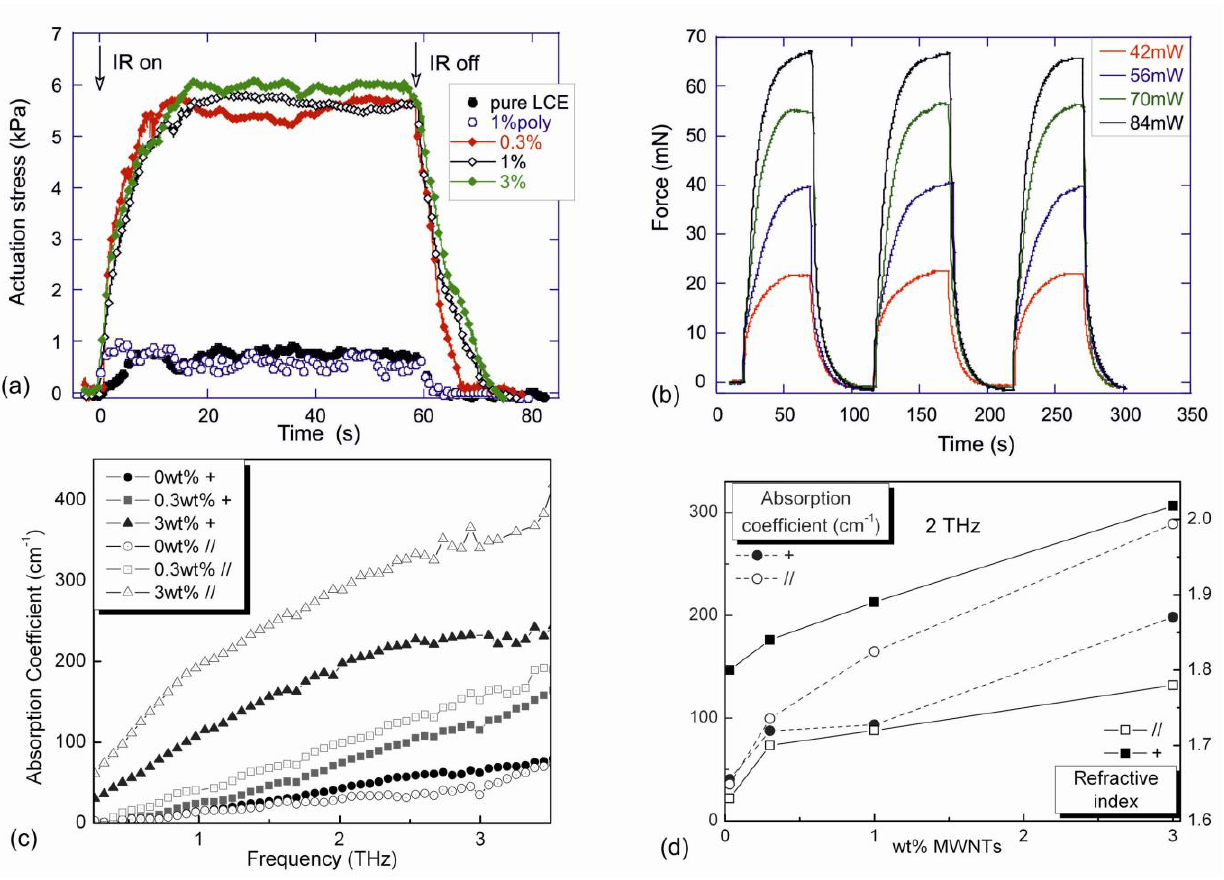
Figure 5. ( a ) Infrared photo-induced actuation in constant-strain geometry, for the samples labelled on the plot; ( b ) The influence of light intensity from a monochromatic light source, showing that the intensity has a considerable effect on the maximum actuation achieved; ( c ) THz time-domain spectroscopy: absorption spectra of a blank, 0.3% and 3 wt% CNT composites when the THz polarization is parallel, //, and perpendicular, +, to the direction of LCEs; ( d ) The absorption coefficient and the refractive index of samples with different CNT concentrations at 2 THz. Uniaxial thermal expansion of nematic elastomers: the comparison between the neat network (•) and the 0.02% CNT composite